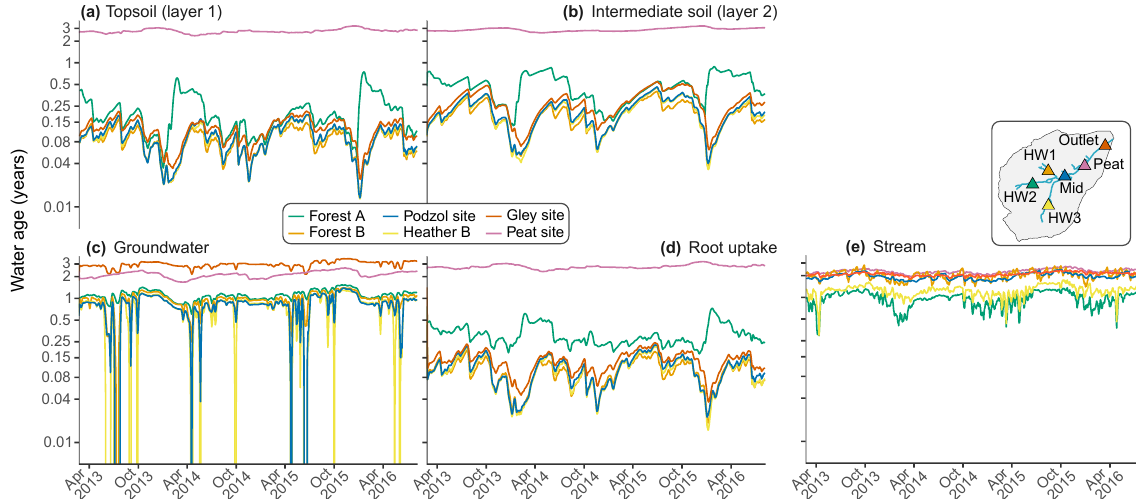
Figure 11. Ensemble median of simulated water age at the different sites used for model evaluation (except for Heather site A) in each corresponding compartment (a–d) , and in the stream at several locations along the channel network (shown on the inset map, e ). To improve visibility, all curves have been smoothed using a 7-day moving average